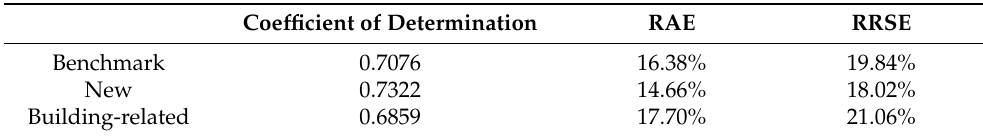
Table 4. The performance of the benchmark and new models.